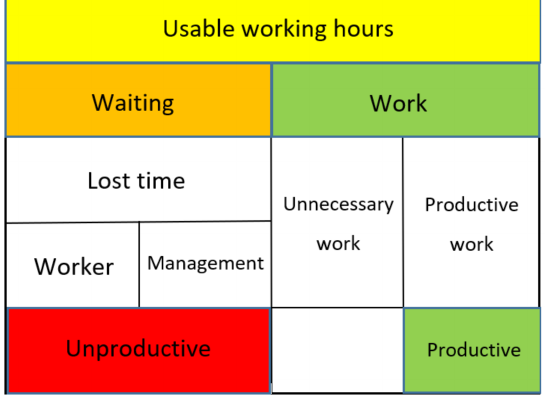
Figure 1. Usable working time